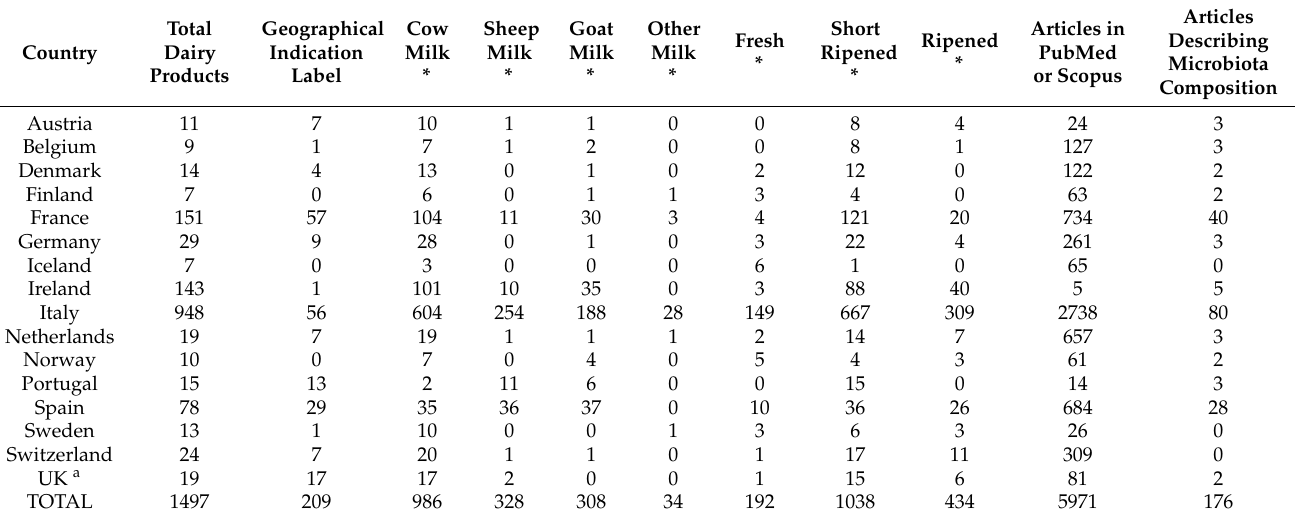
Table 3. Distribution of the identified traditional dairy products, along with their characteristics and related articles, within Western Europe